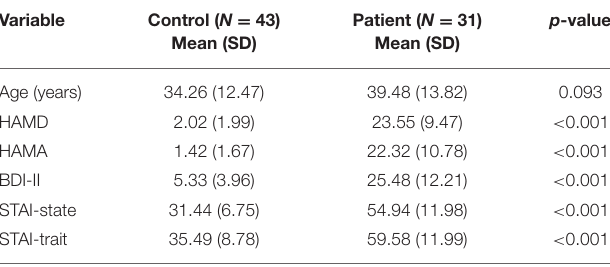
TABLE 1 | Participant demographic data ( N =